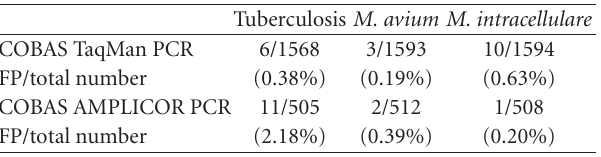
Table 5: False positive result of COBAS TaqMan PCR and COBAS AMPLICOR